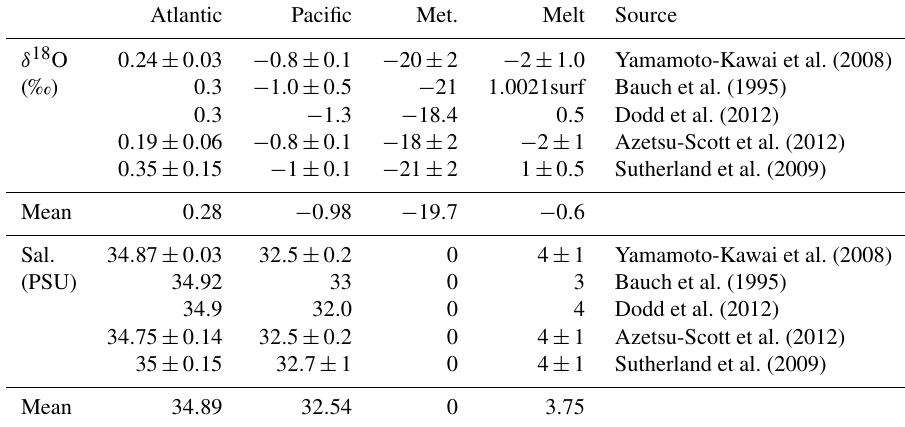
Table 2. End-member values for salinity and δ 18 O (‰) from the literature. Note Bauch et al. (1995) calculate ice melt δ 18 O by multiplying